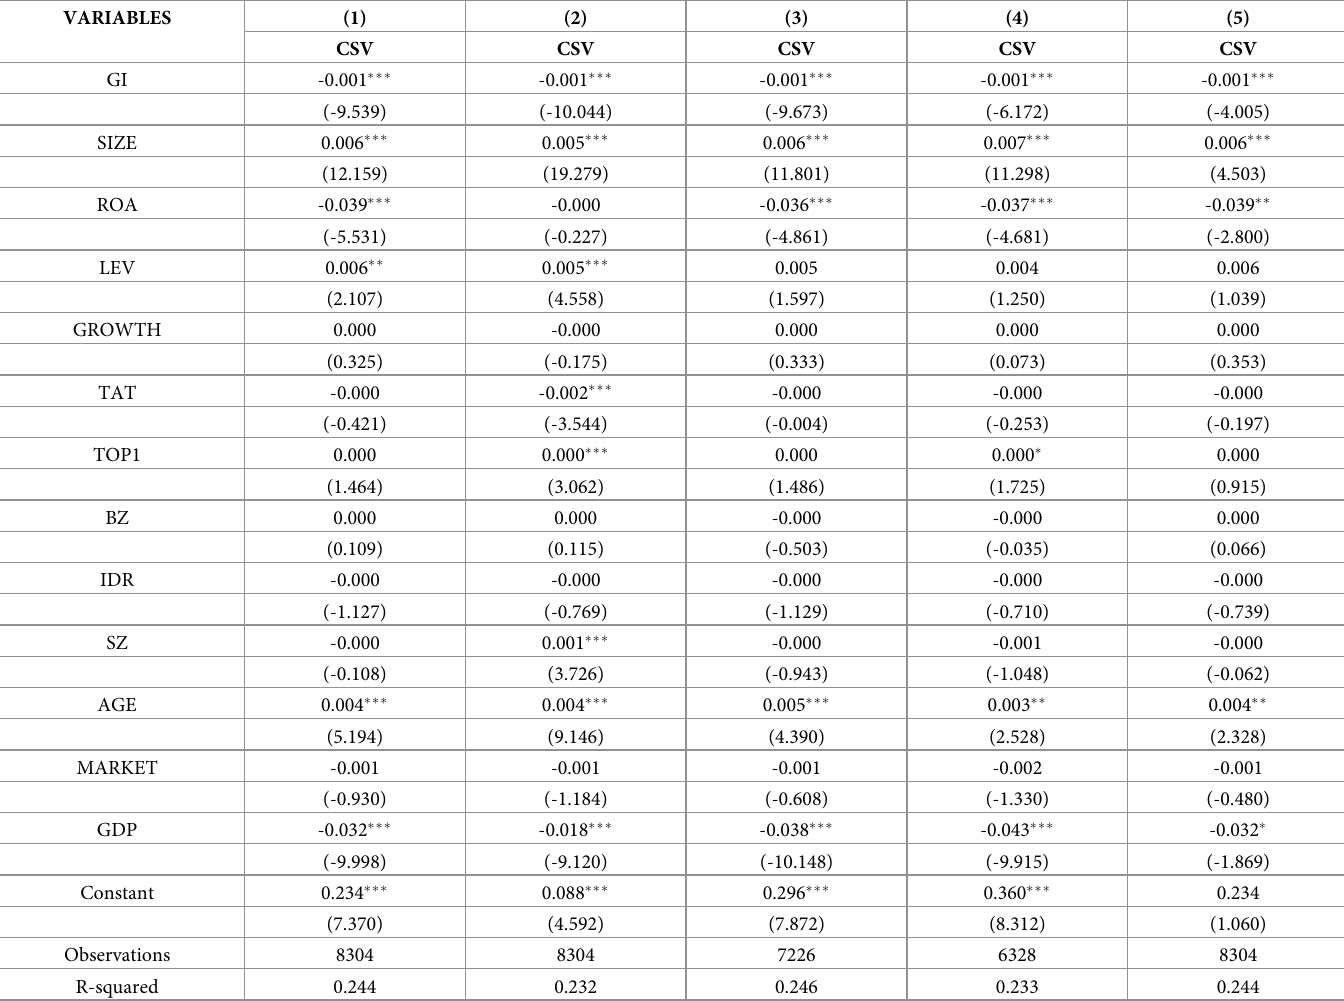
Table 6. Regression results of Sustainability reporting “greenwashing” and “shared value”